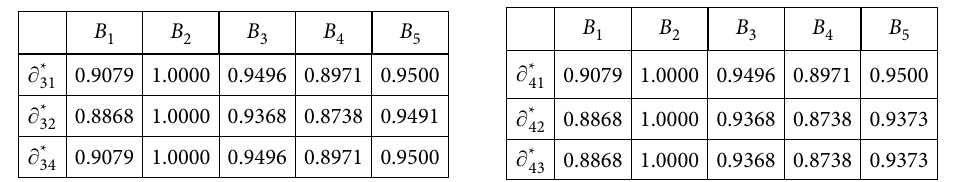
Table 10. The modified weights